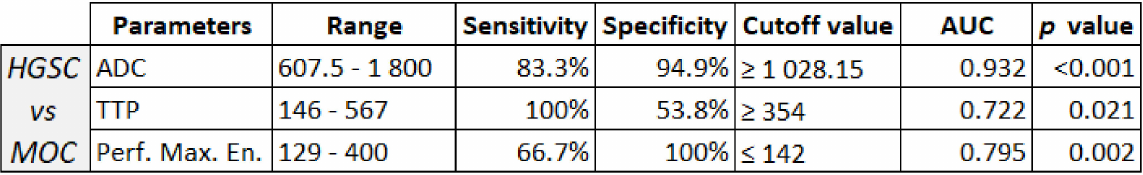
Scheme 5. Table with the results obtained during the analysis of three ROC curves for three quantitative